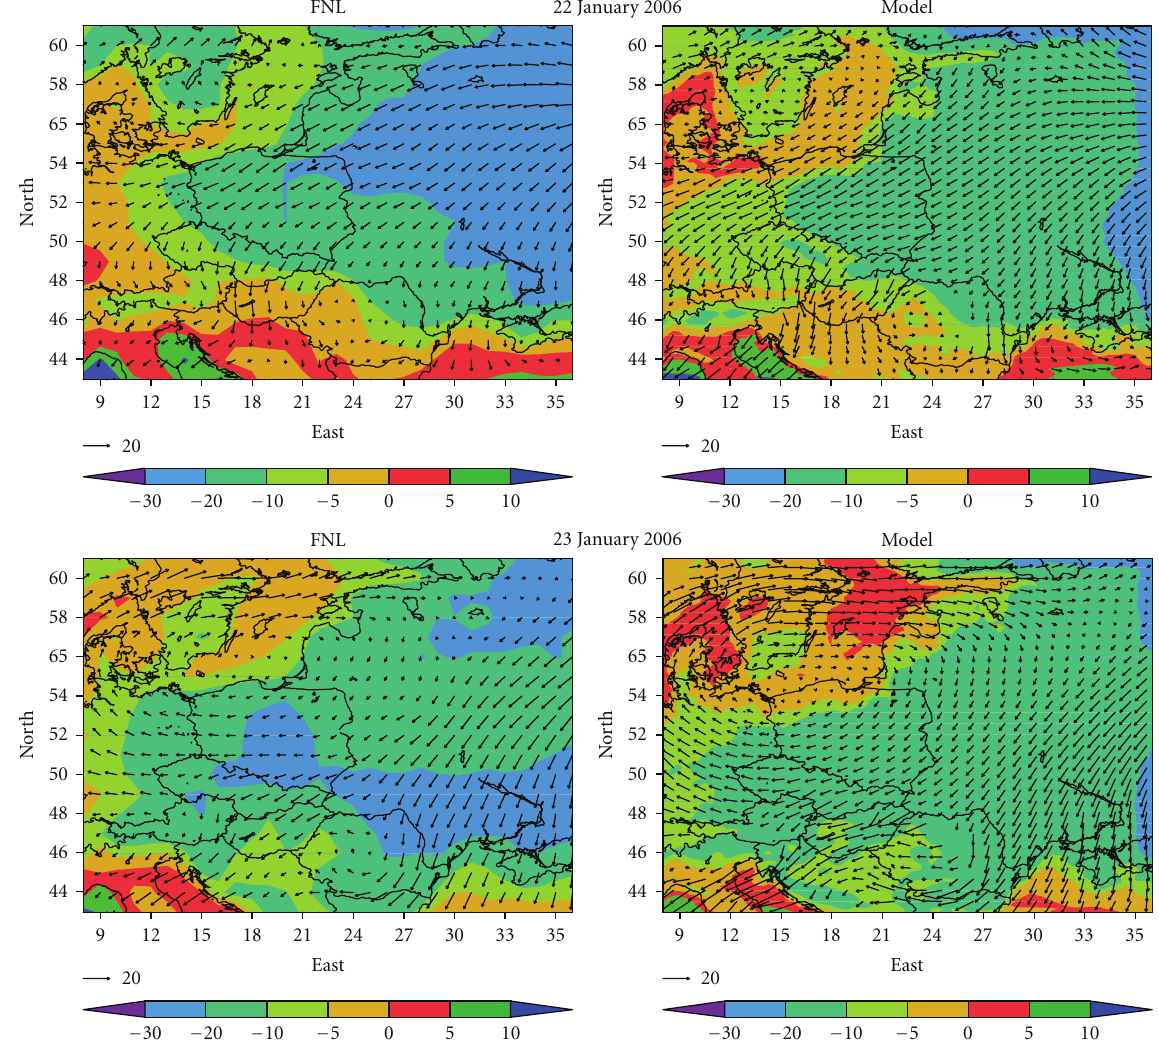
Figure 5: Daily mean temperature (C) at 2m (shaded) along with winds at 925 hPa for FNL (left panel) and ARW model (right panel) at di ff erent